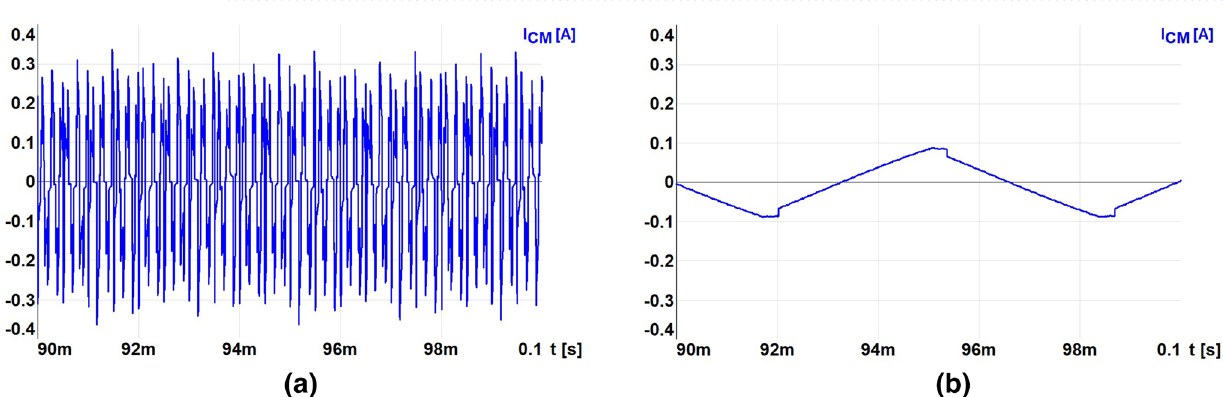
Figure 13. The CM ground leakage current on 1 k (cid:31) (human touch): ( a ) without CM filter capacitances, ( b ) with CM filter